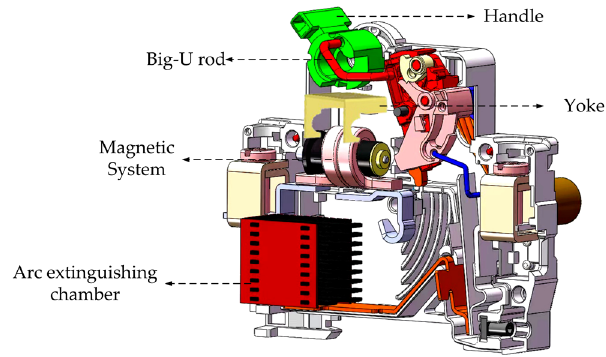
Figure 1. Internal structure and parts composition of a